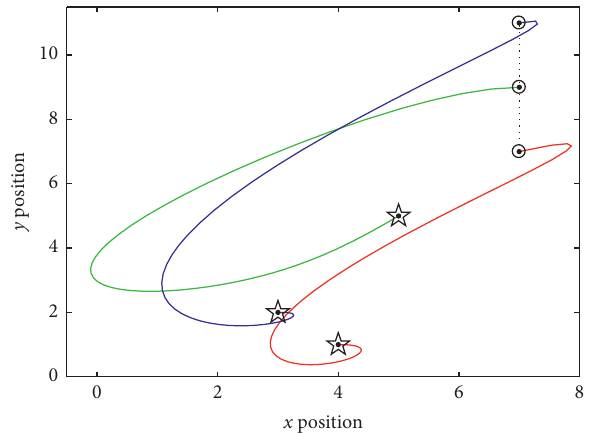
Figure 6: A straight configuration.